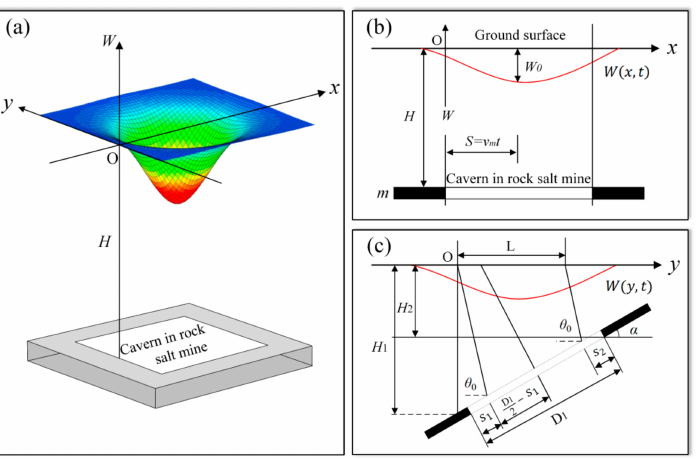
Figure 1. Schematic diagrams for the coordinate system: ( a ) 3D view of the coordinate system; ( b ) profile along strike direction; ( c ) profile along dip